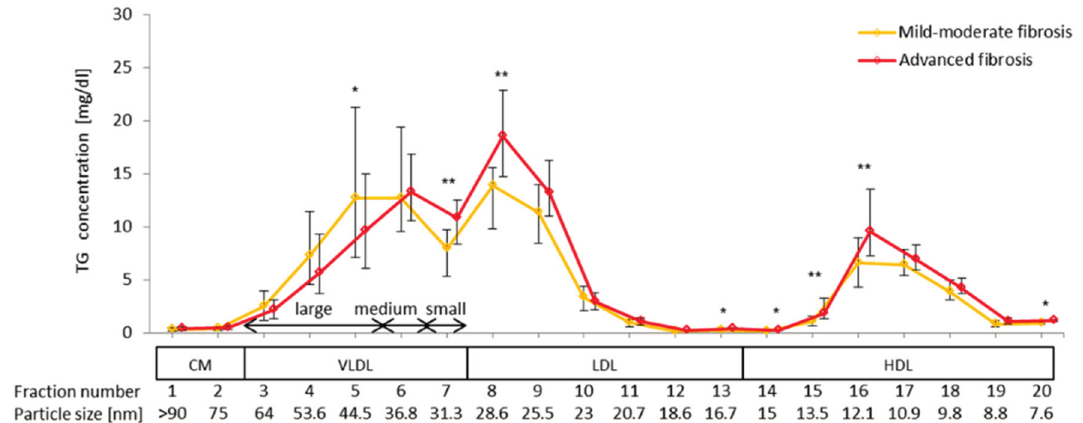
Figure 4. Comparison of TG concentrations in lipoprotein sub-fractions between patients with advanced fibrosis and those with mild-moderate fibrosis. Serum lipoprotein was fractionated by HPLC into 20 fractions according to the particle size, and the concentration of TG in each fraction was measured using an online detection system (Skylight Biotech, Inc., Akita, Japan). The fraction number and the mean particle size of each fraction are presented at the bottom of the image ( * p < 0.05; ** p < 0.01). 2.7. Impact of Advanced Liver Fibrosis on TG Concentration in the Four Serum Lipoprotein Classes in Patients with Chronic Active HCV G1b Infection With regard to the distribution of TG in the four major classes of serum lipoprotein, LDL-TG (median 33.7, IQR 13.8 vs. median 29.2, IQR 13.5, p = 0.02) and HDL-TG (median 21.7, IQR 10.1 vs. median 20.0, IQR 6.6, p = 0.03) were significantly higher in patients with advanced fibrosis, while VLDL-TG (median 38.7, IQR 22.3 vs. median 42.8, IQR 32.9, p = 0.3) was not different between